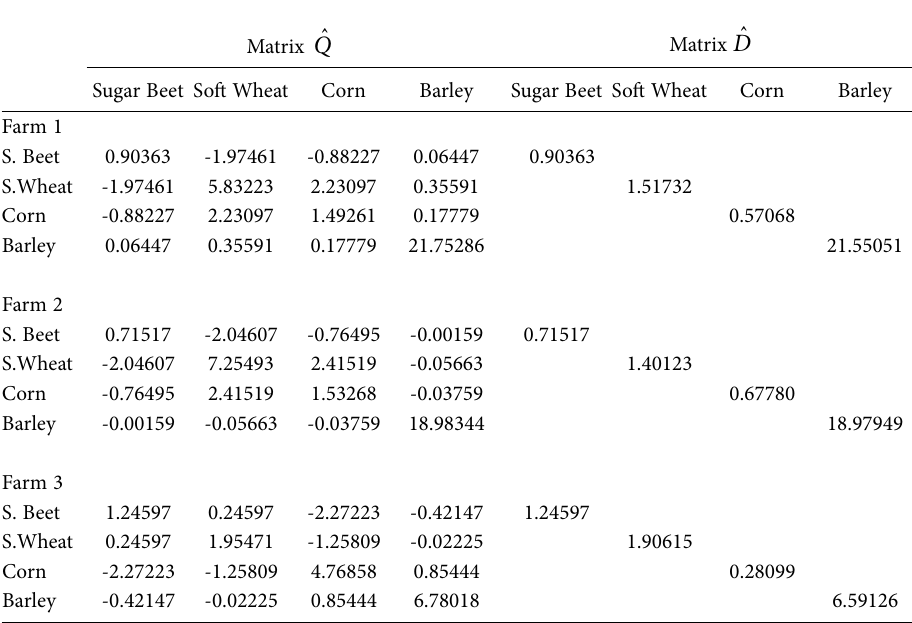
Table 4. Matrices Q ˆ and D ˆ for three